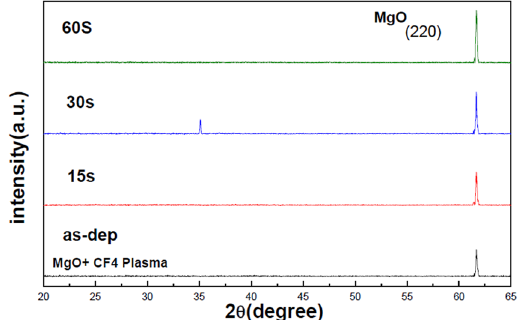
Figure 3. XRD of MgO films with CF 4 plasma treatment in various conditions.